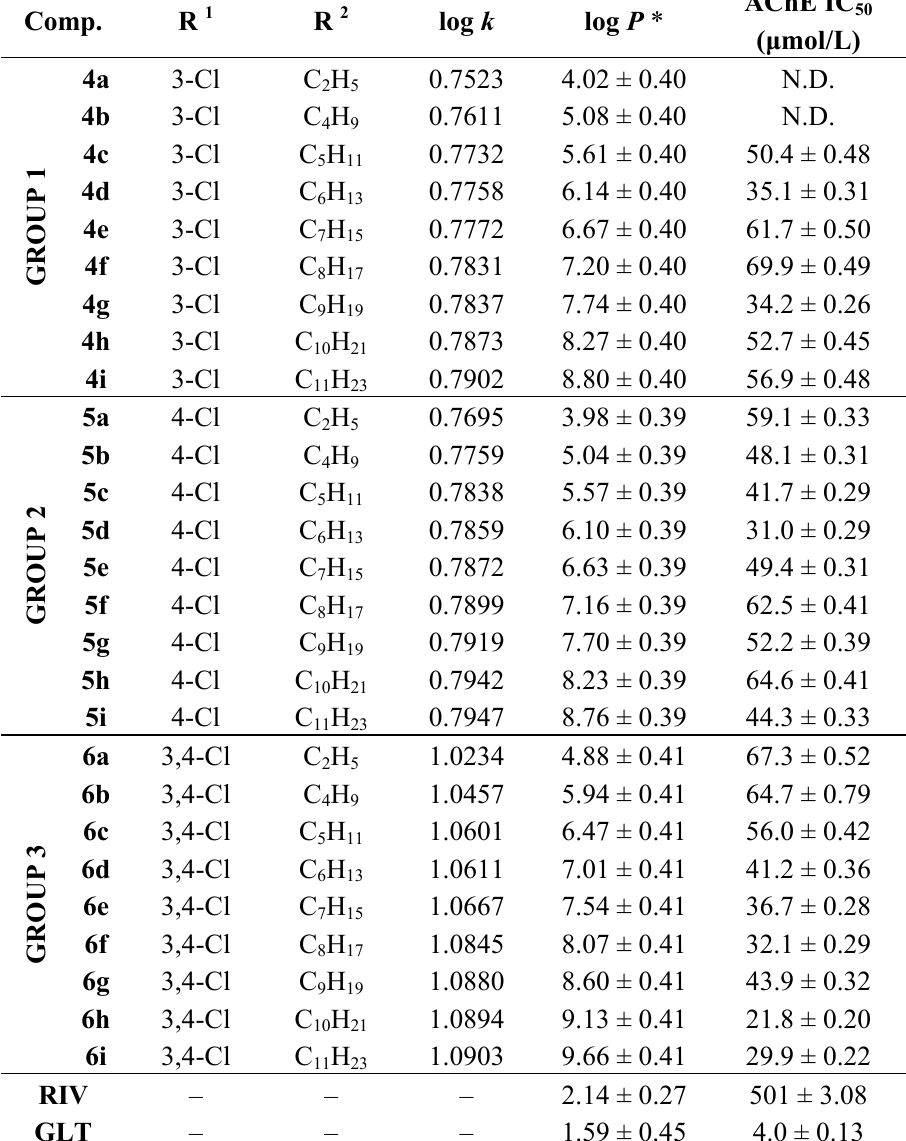
Table 1. IC Values of AChE inhibition in comparison with standards rivastigmine (RIV) 50 and galanthamine (GLT) and lipophilicity values (log k , log P ). AChE inhibition is expressed as mean ± SD ( n = 3 experiments), (N.D. = not determined; * calculated by ACD/LogP (ver. 1.0), Advanced Chemistry Development Inc., Toronto, Canada).